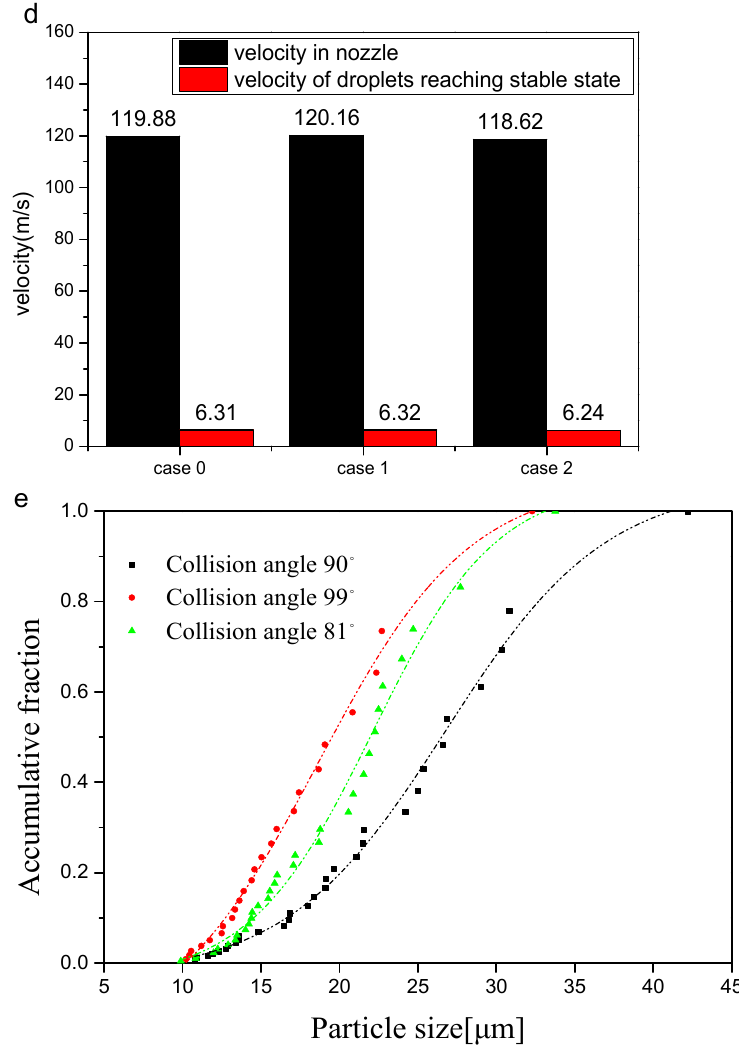
Figure 7. Comparison of ( a ) collision angle of liquid flow; ( b ) atomization of the liquid phase; ( c ) spray angle; ( d ) velocity; and ( e ) particle size distribution between cases 0, 1, and 2.